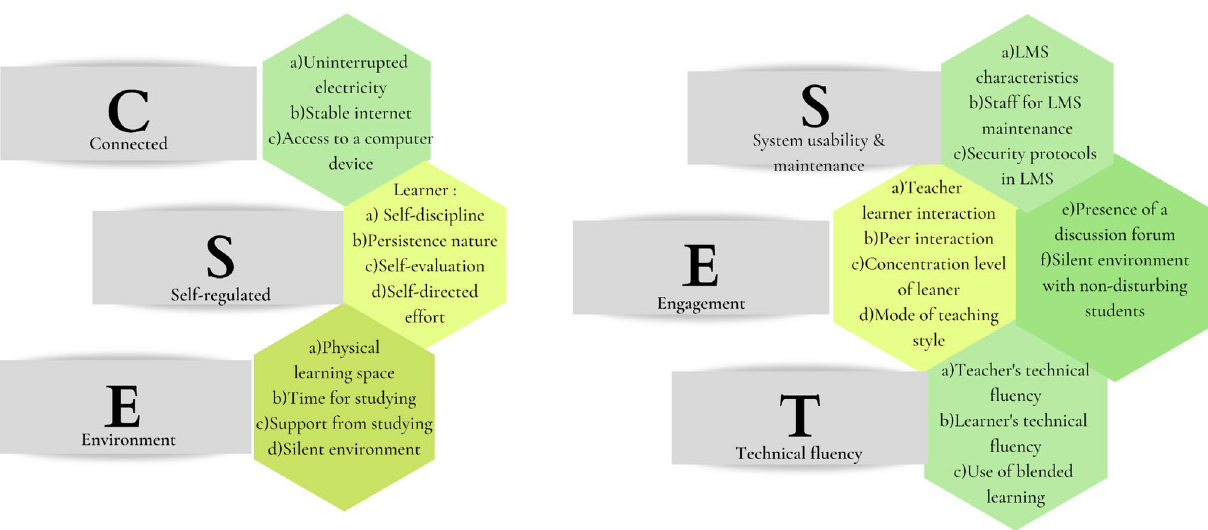
Fig. 5 The essentials for online learning: